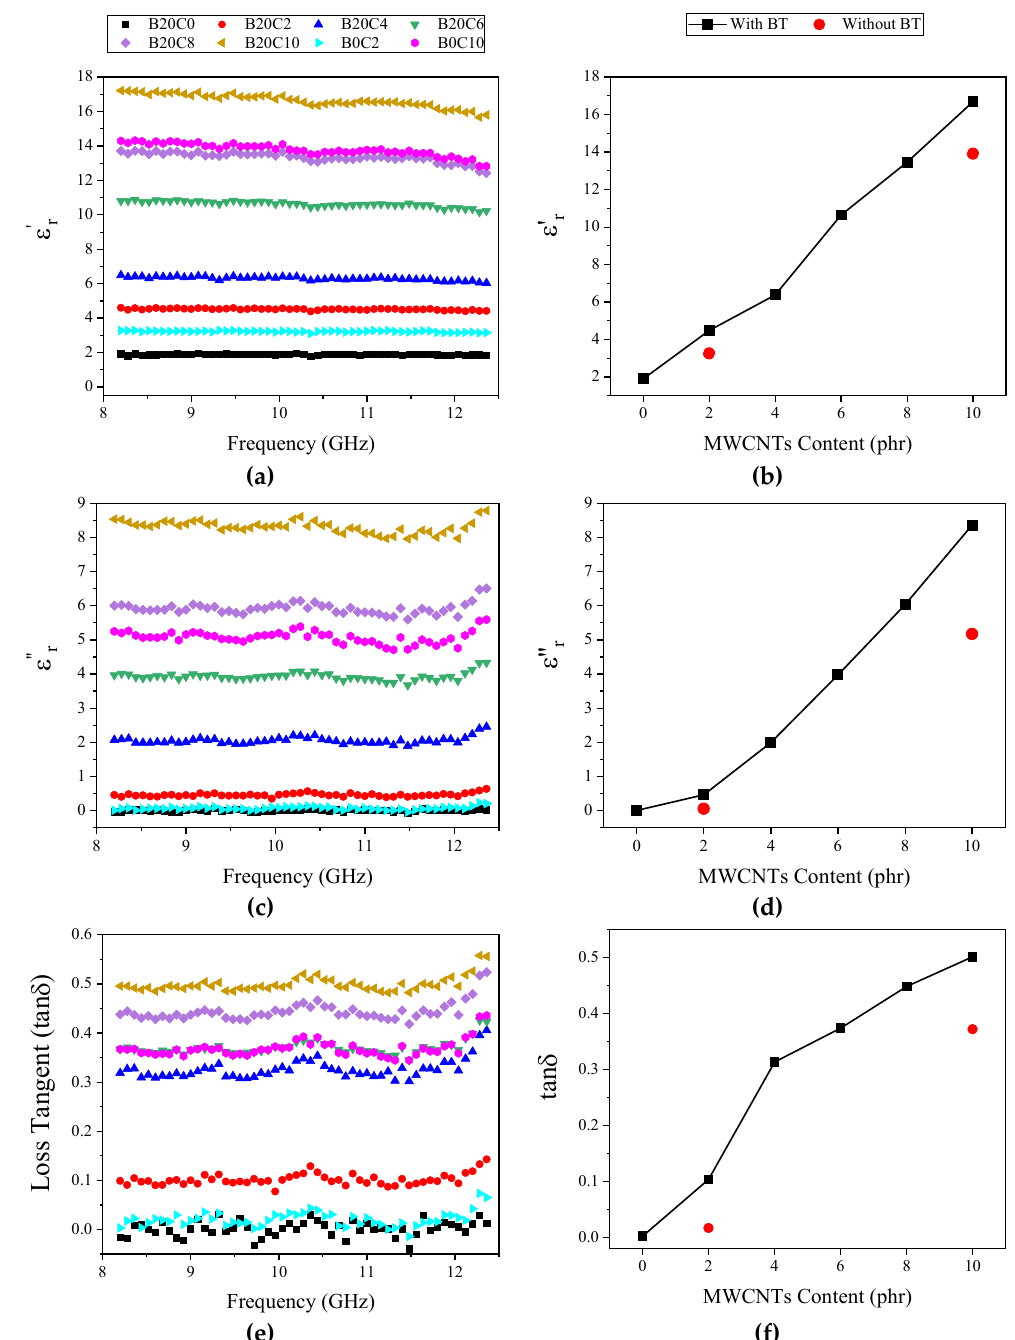
Figure 5. Dielectric permittivity of the foamed samples in the X-band: ( a , b ) real part, ( c , d ) imaginary part, ( e , f ) loss tangent as a function of the frequency ( a , c , e ) and as a function of the MWCNTs loading fraction at 10 GHz ( b , d , f ).